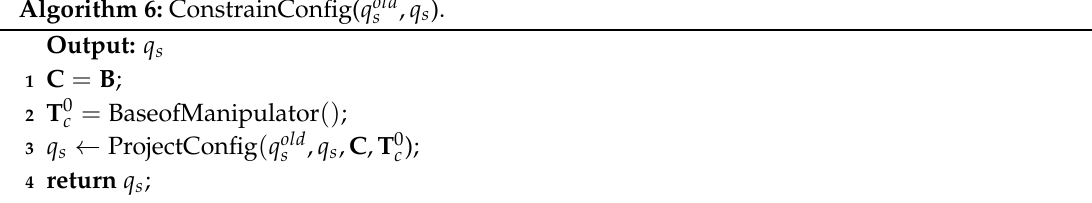
Algorithm 6: ConstrainConfig( q old